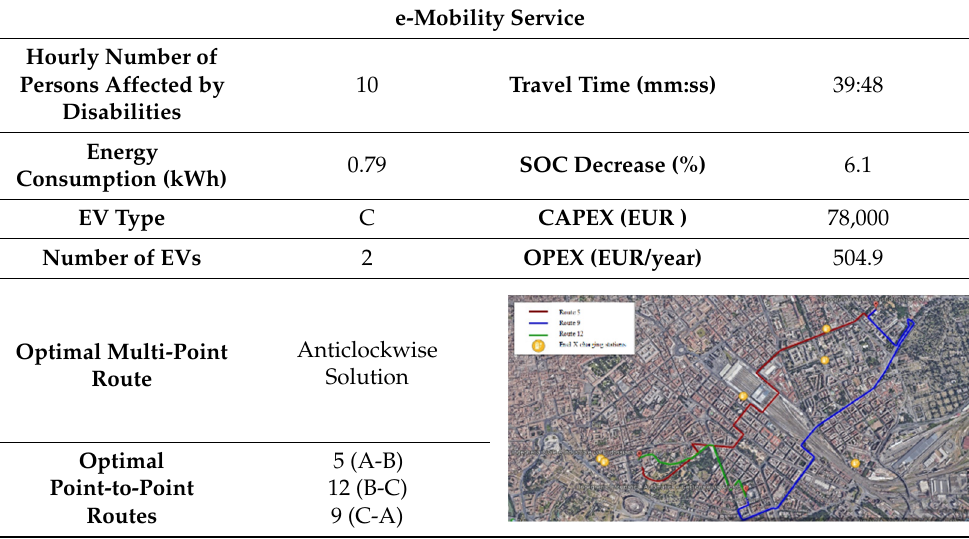
Table 4. e-mobility service results.